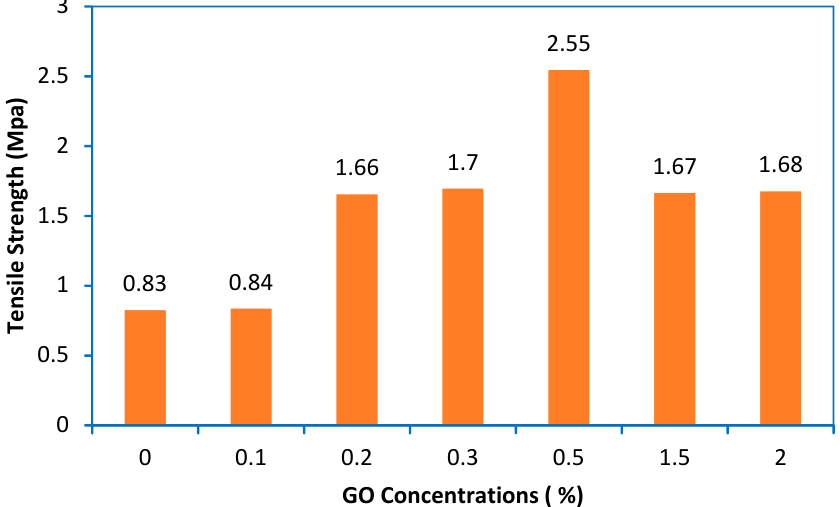
Figure6. Figure 6. Effect of GO concentrations in casting solution on the tensile strength of the composite membranes.